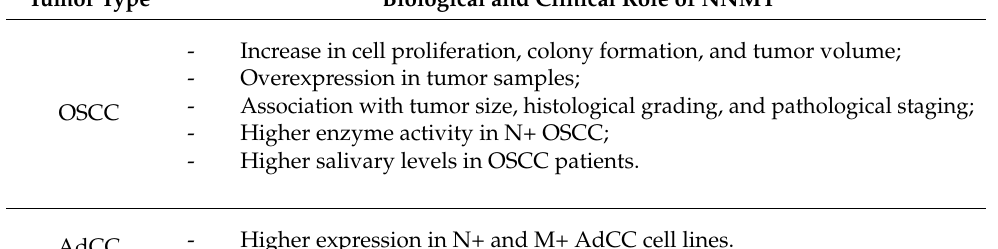
Table 2. Main findings regarding the role of NNMT in HNT. Tumor